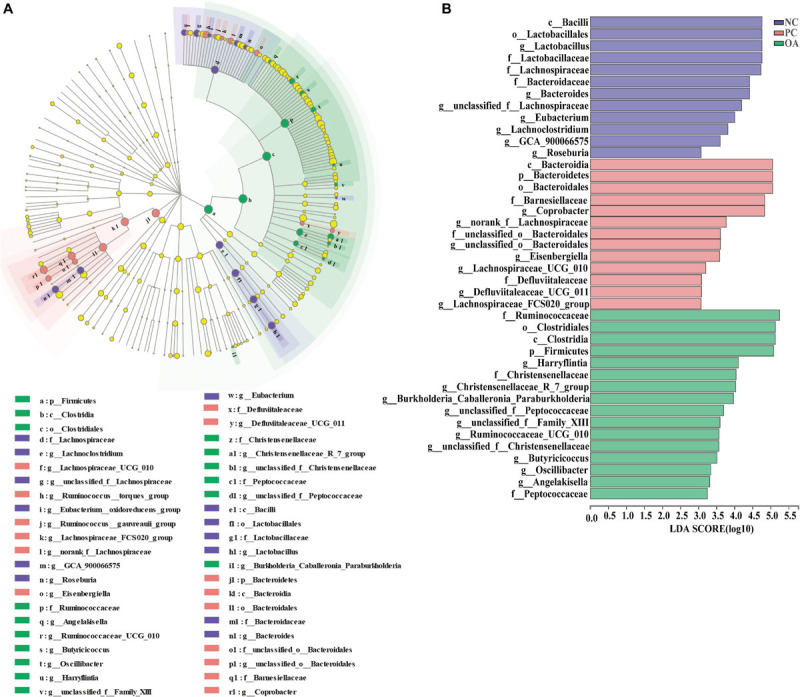
Linear discriminant analysis effect size (LEfSe) identified the most differentially abundant taxa enriched in cecal microbiota of broilers among the groups on day 42. (A) cladogram generated from LEfSe analysis; (B) histogram of the LDA scores computed for features differentially abundant (LDA > 3, P < 0.05). NC, negative control supplied with the basal diets; PC, positive control supplied with the basal diets and 5 mg/kg flavomycin; OA, the basal diets supplied with 0.3% (day 0–21) and 0.2% (day 22–42) organic acids feed additives.